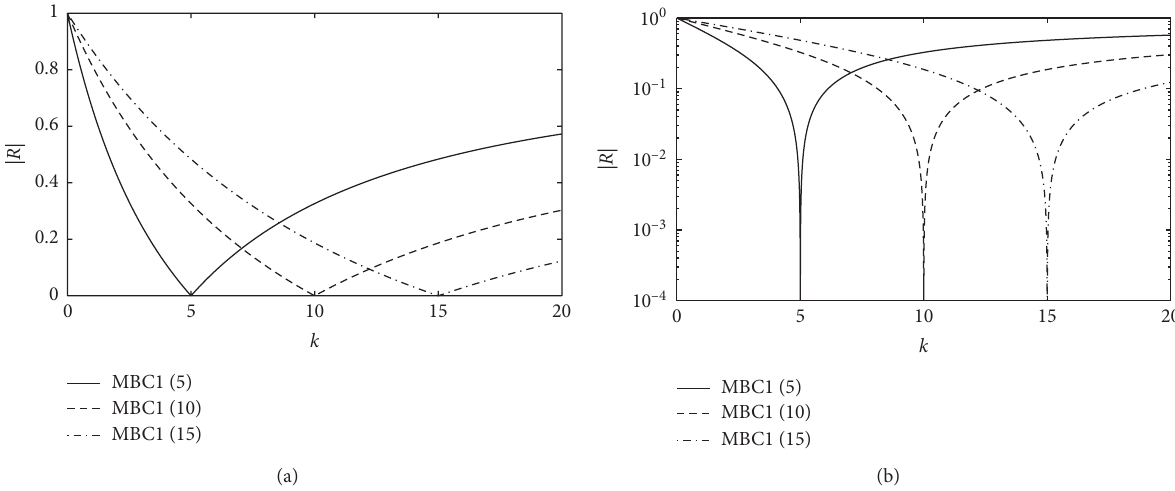
Figure 3: Reflection coefficient modulus for MBCs with a single wave number matched: (a) linear axis for reflection coefficients modulus; (b) logarithmic axis for reflection coefficients modulus.